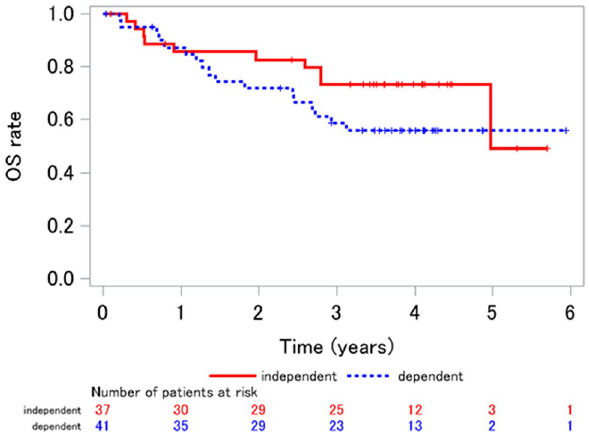
Figure 2. Overall survival curves for DLBCL cases classified as independent and dependent according to a CGA. Red line: independent group (n = 37). Blue line: dependent group (n = 41). The median overall survival (OS) was 4.98 years (95% confidence interval [CI] 2.79–) in the independent group but was not reached in the dependent group (95% CI 1.82–), respectively (log-rank analysis: p = 0.180). CGA, Comprehensive Geriatric Assessment; DLBCL, diffuse large B-cell